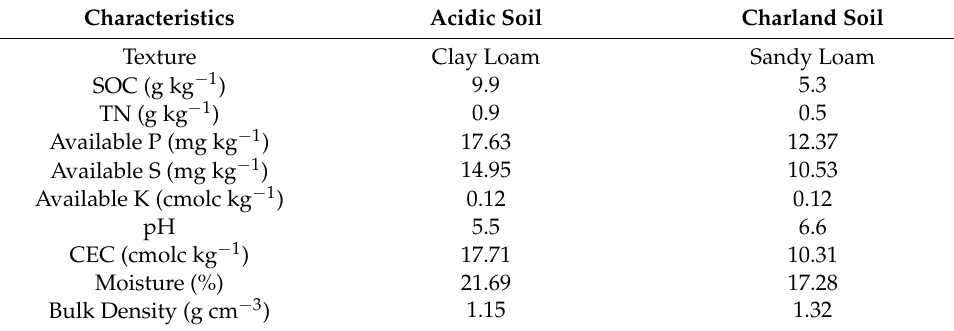
Table 1. Initial soil properties for acid soil and charland